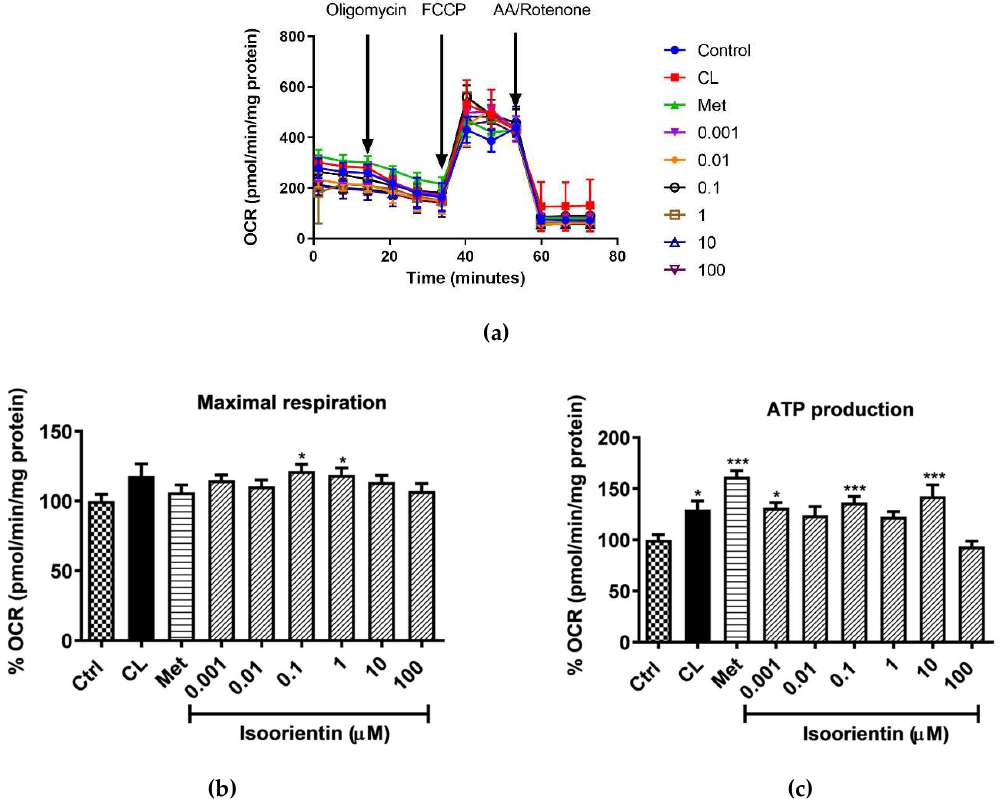
Figure 3. Isoorientin enhances mitochondrial respiration in fully differentiated 3T3-L1 adipocytes, ( a ) representative oxygen consumption rate (OCR) plot; ( b ) maximal respiration; and ( c ) ATP production. Matured 3T3-L1 adipocytes were treated with or without positive control CL-316,243 (CL 1), isoproterenol (Isopr ) used at 1 μM and various doses of isoorientin (0.001, 0.01, 0.1, 1, 10, and 100 μM) for 4 h; thereafter, mitochondrial respiration was measured using a Seahorse XF analyzer. Results are expressed as mean ± SEM of three independent experiments. * p < 0.05, *** p ˂ 0.001 versus normal control (Ctrl). The numbers 0.001, 0.01, 0, 1, 1, 10, and 100 represent the isoorientin concentration used in μM units.